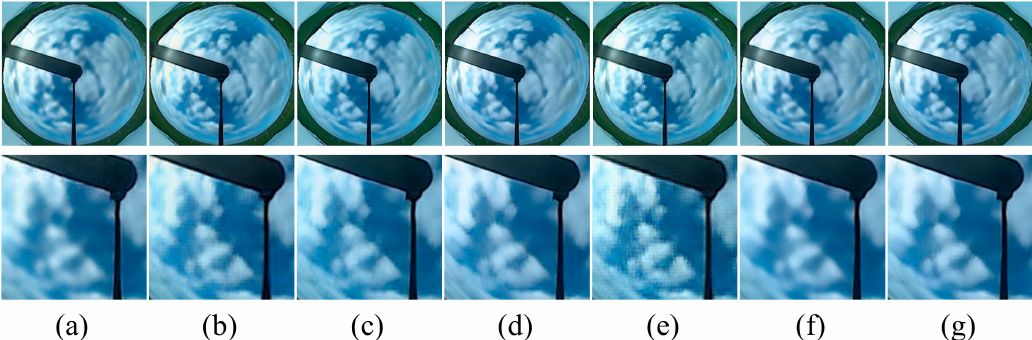
Figure 11. The results of the above several attempts and their partial enlargement: ( a ) test 1; ( b ) test 2; ( c ) test 3; ( d ) test 4; ( e ) test 5; ( f ) test 6; ( g ) test